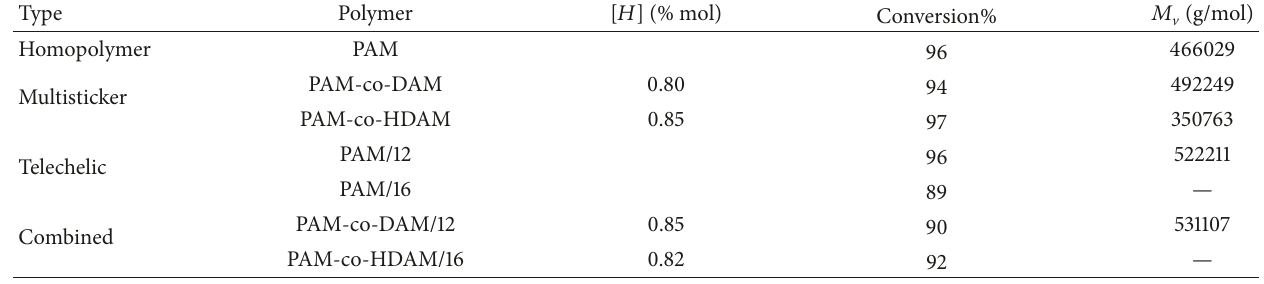
Table 2: Percentages of hydrophobic monomer incorporated for emulsion polymers, 4% solids contents.